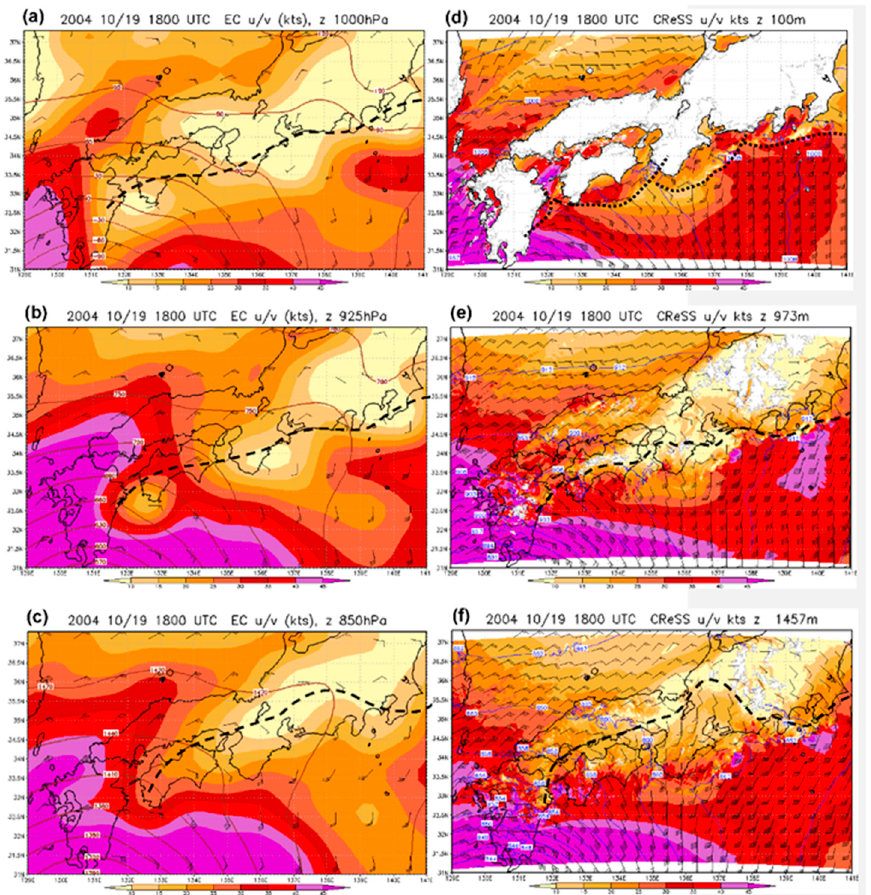
Figure 5. The ECMWF gridded analyses of geopotential height (gpm, contours, every 30 gpm) and horizontal winds (kts, wind barbs with speed shaded) at 1800 UTC 19 October 2004 at ( a ) 1000 hPa, ( b ) 925 hPa, and ( c ) 850 hPa, respectively. Thick, dashed lines depict the location of fronts or wind-shift lines. ( d – f ) Same as ( a – c ), except from CReSS model simulation of pressure (hPa, isobars plotted every 3 hPa) and winds at ( d ) 100 m, ( e ) 973 m, and ( f ) 1457 m, respectively (areas with a terrain higher than the plotting height are left blank). The scales for wind speed (shown at bottom) are the same in all panels. The thick dotted lines in ( d ) depict the location of arc-shaped rainbands as seen in Figure 6c.